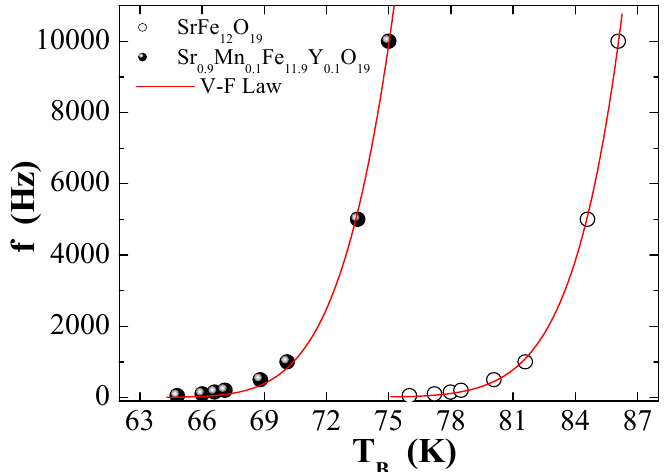
Figure 12. Frequency dependent T B for two selected Sr 1 − x Mn x Fe 12 − y Y y O 19 (x = y = 0.0 and 0.1) nanohexaferrites where solid line presents Vogel–Fulcher (V–F) law fit.